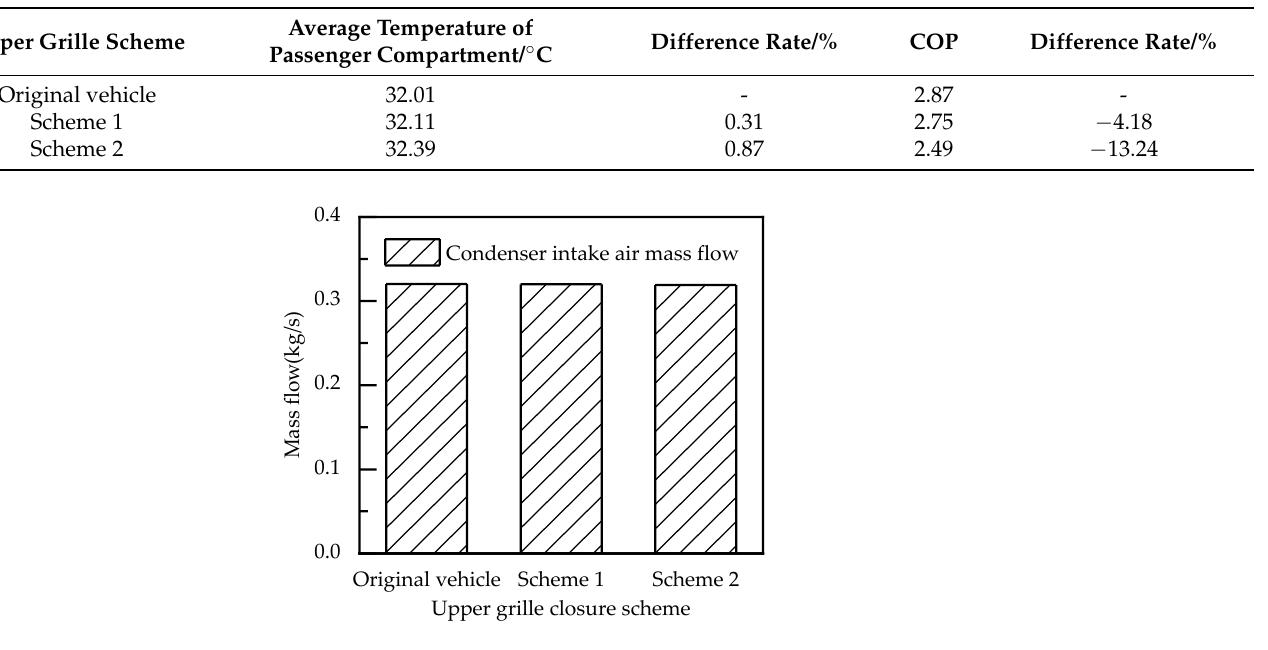
( c ) Figure 16. Velocity fields of z = 0.44m section under different upper grille closure schemes: ( a ) original vehicle; ( b ) scheme 1; ( c ) scheme 2.